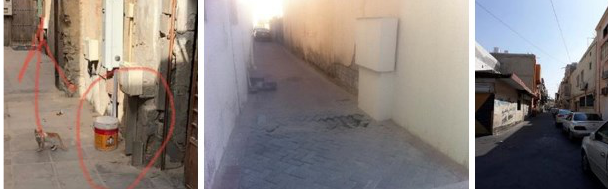
Figure 20. Low level of understanding of the know-how of dealing with identity